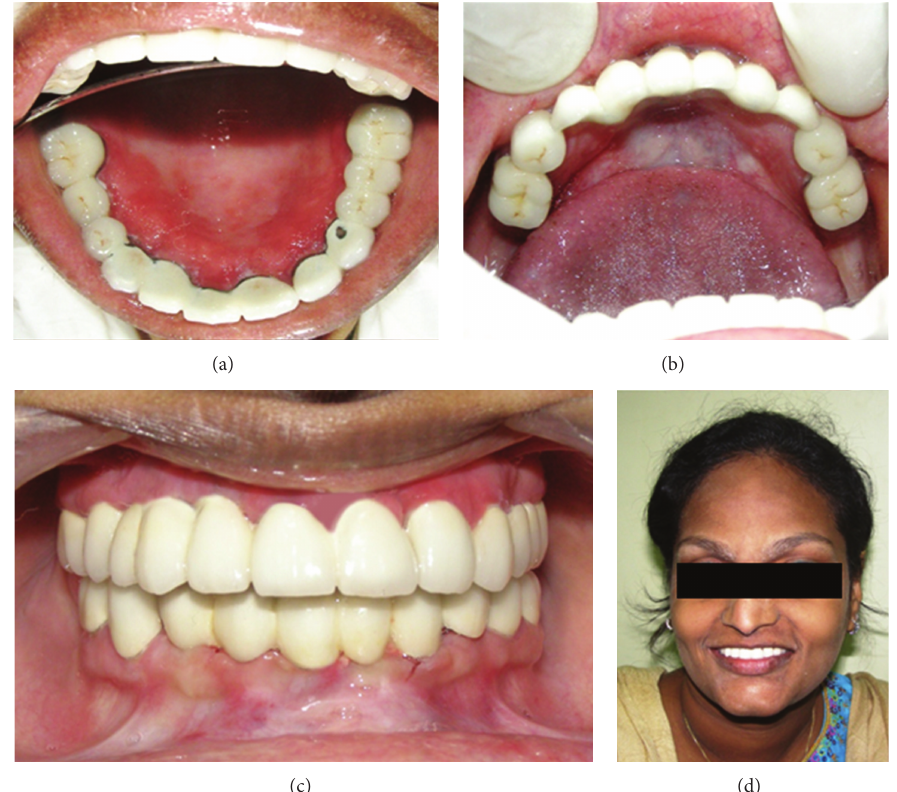
Figure 8: Occlusal view of the prosthesis, maxillary arch (mirror image) (a), mandibular arch (b) (mirror image), in occlusion (c), and patient’s smile